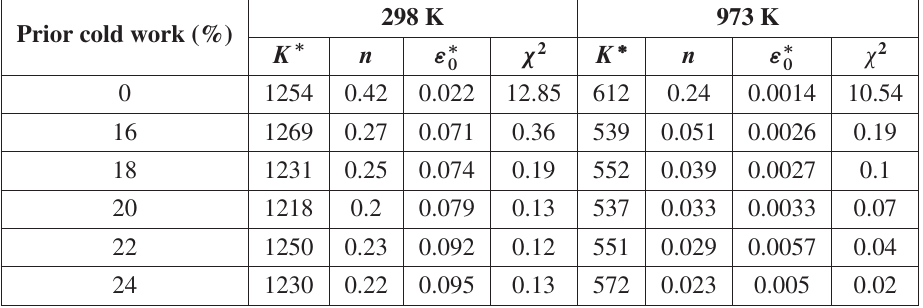
Table 2. Parameters derived from Swift equation for test temperatures of 298 K and 973 K.